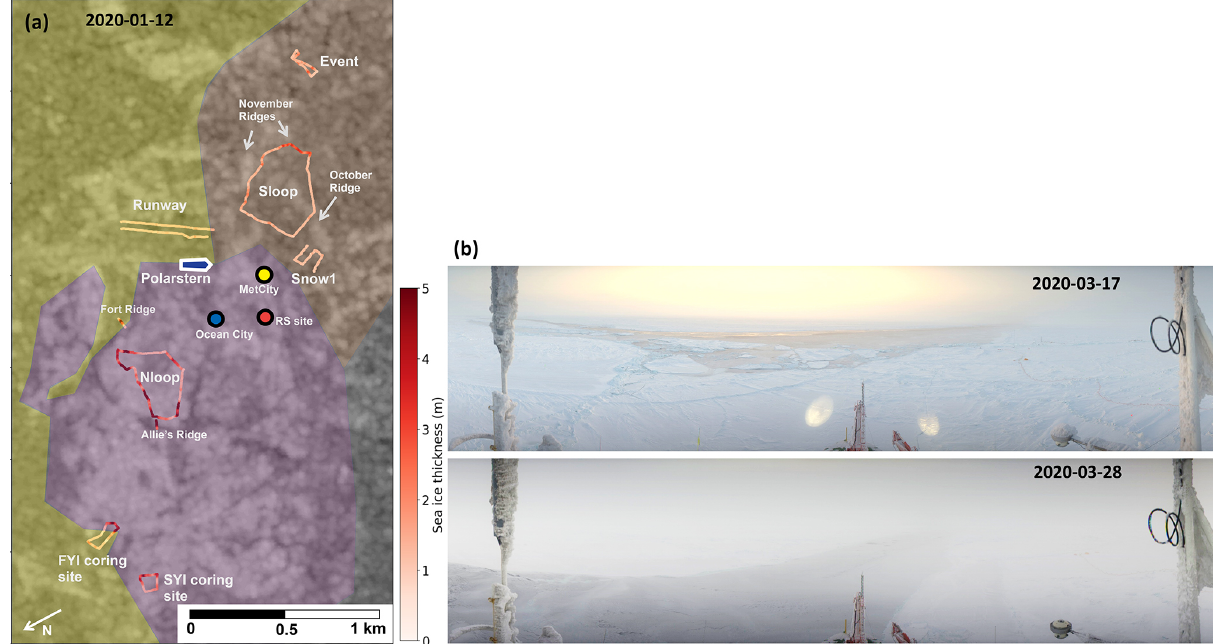
Figure 9. (a) Manual sea ice classification of the CO overlaid on a RS2 SCW scene (HH) on 12 January 2020. The color code used in the figure is as follows: yellow – FYI; purple – rough SYI; and red – ponded SYI. The RV Polarstern , weather stations, and transects with sea ice thickness measurements are also shown. Panel (b) shows two respective panoramic photographs taken from RV Polarstern on 17